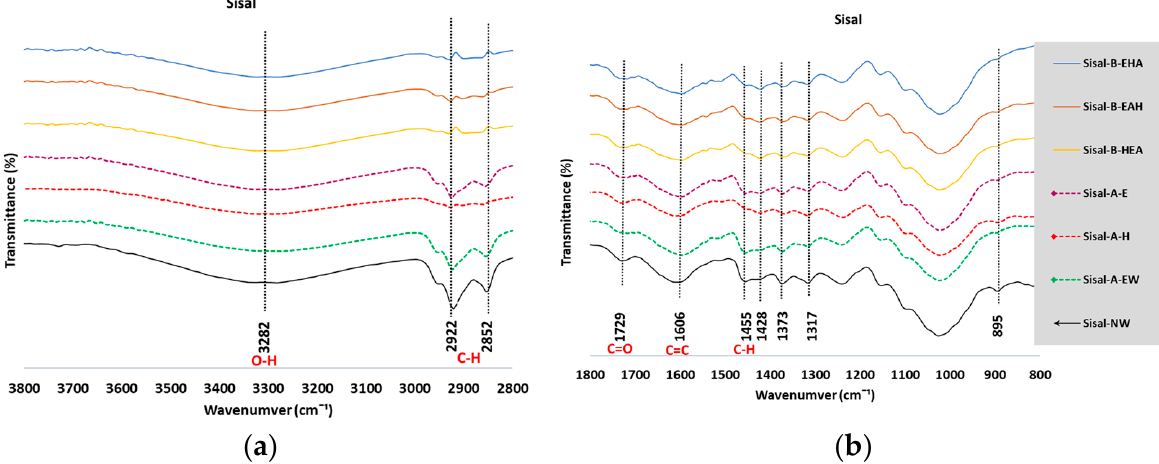
Figure 4. Spectra of sisal fibers before washing (NW) and after washing (B-EHA, B-HEA, A-E, A-H, B-EAH, A-EW). ( a ) Range 2800–3800 cm − 1 , ( b ) range 800–1800 cm − 1 .